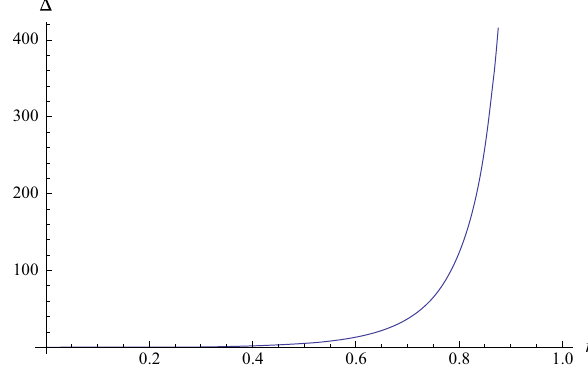
Fig. 7 Anisotropy (cid:10) with n = 1 ,α = 0 . 025 and d = 0 . 0804 ) . Also, (cid:10) vanishes negativity of the pressure gradient ( dP r dr at r = 0, on initial working singular point was observed at r = 0 in charge density that was removed by taking suitable value of parameter “ c ”, metric functions remain positive and central density continues to be